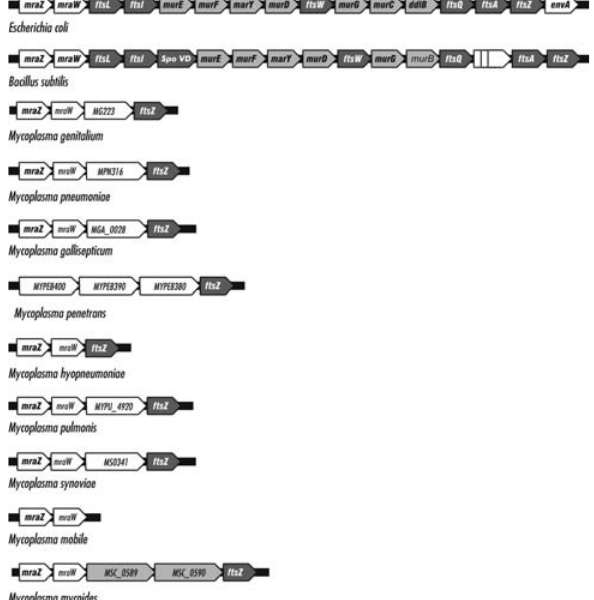
Figure 1 - Comparison of the organization of genes of the dcw cluster in mycoplasmas. The organization of the genes in E. coli and B. subtilis is also presented for